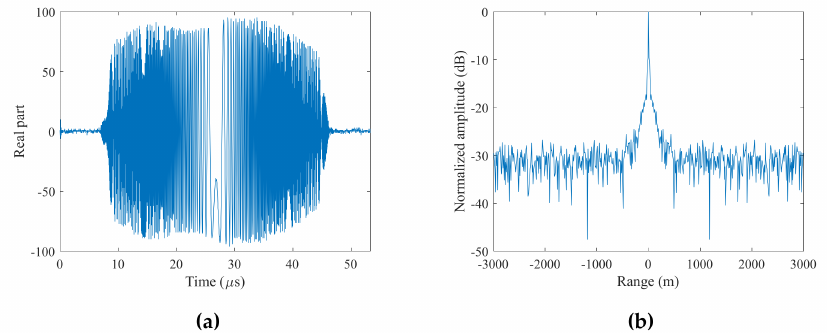
Figure 3. ( a ) Real part of a received signal pulse (IW 3) and ( b ) its range ambiguity function, showing a bistatic range resolution of 10 m with the SDR receiver setup limited to a 30 MHz bandwidth.